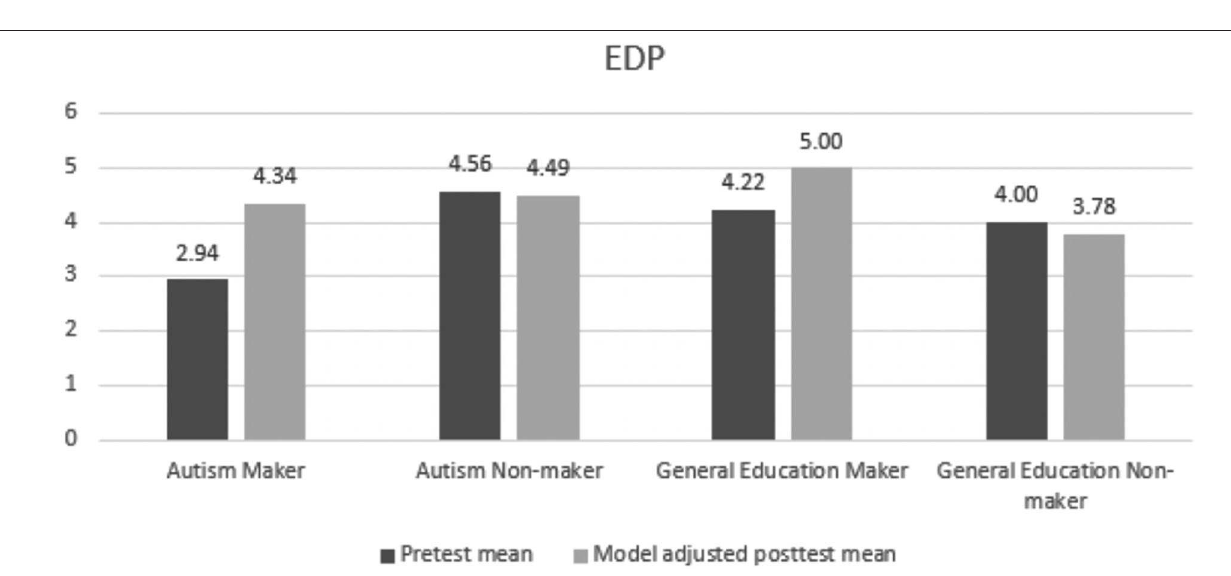
Tinkercad software ( Figure 9 ) and prototyping and finalizing their final 3D printed objects ( Figure 10